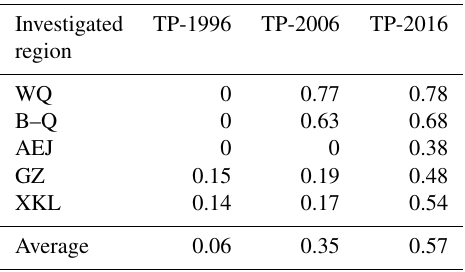
Table 3. Kappa coefficient statistics in five investigated regions of three